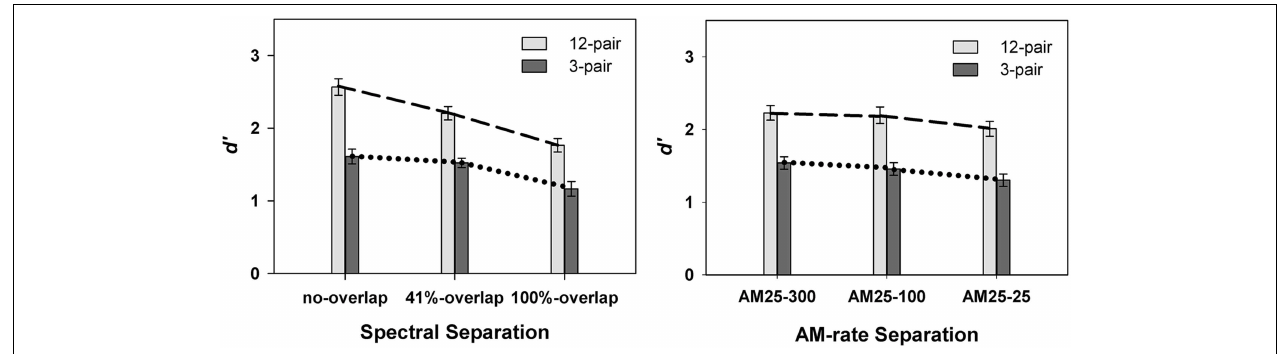
panel) (error bars represent ± one standard errors). Significance was found for the interaction of spectral separation X sequence duration, but not for the interaction of AM-rate separation X sequence